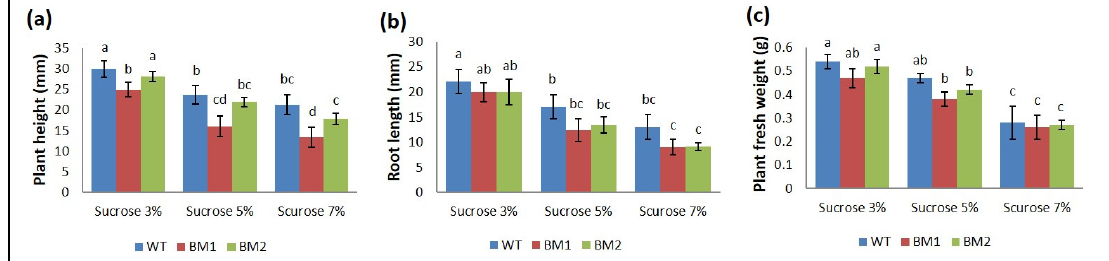
Figure 5. Effect of sucrose on growth attributes ( a ; plant height, b ; root length, c ; plant fresh weight) in transgenic torenia overexpressing mPAP1 + B-Peru and wild type (WT) plants. Data represent the means of three replicates. Error bars indicate standard error. Groups annotated with the same letter are not significantly different by Duncan Multiple Range Test (DMRT, p < 0.05).